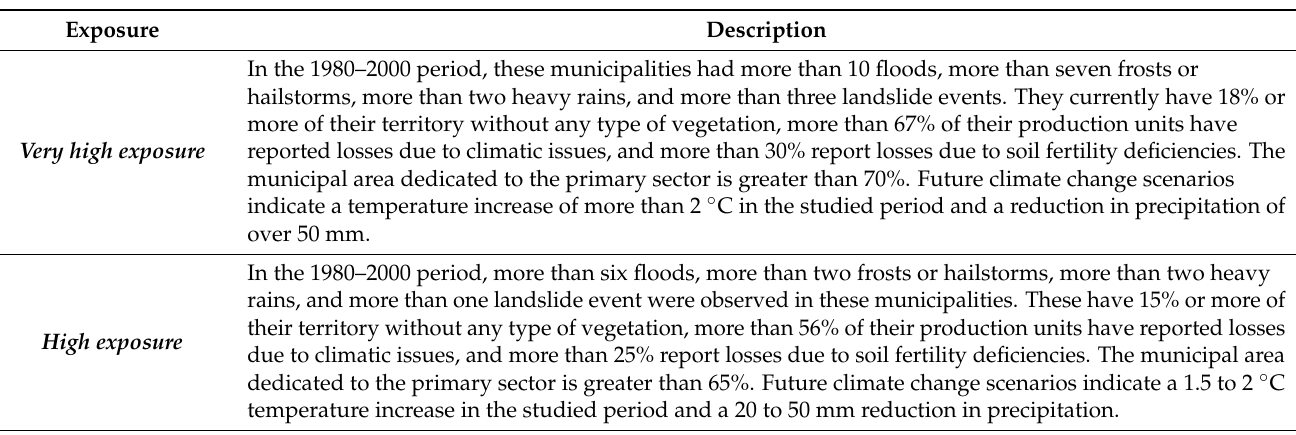
Table 6. Degrees of exposure to climate change in Mexican